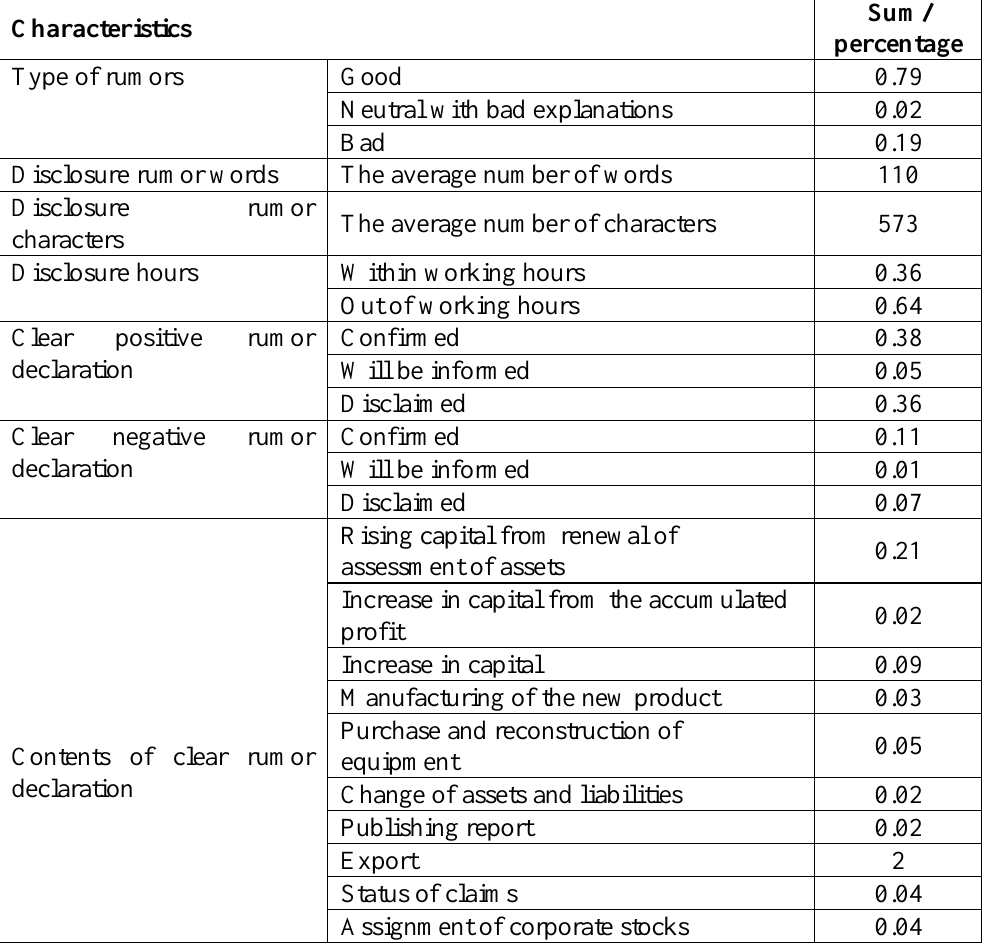
Table 2. Summarized statistics of a group of data for clear rumor declarations in TEDAN system and CODAL